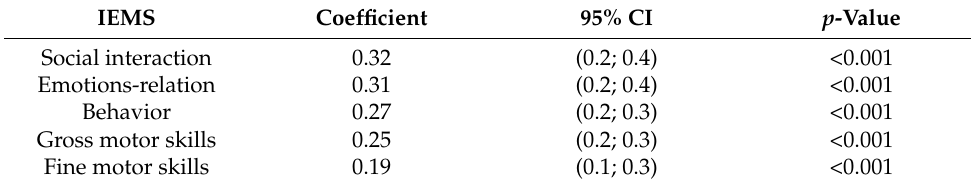
Table 5. Association between the EAAT and the IEMS